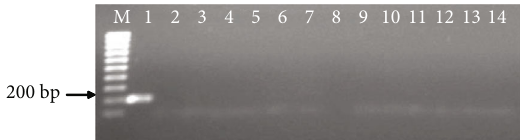
Figure 2: Ampli fi cation of 14 female reniform nematodes using bacterial primers. M: 100 bp marker; 1: Pseudomonas DNA (+ve control); 2: sterilized DNAse-free water (-ve control); 3-14 are reniform nematode ampli fi cations.